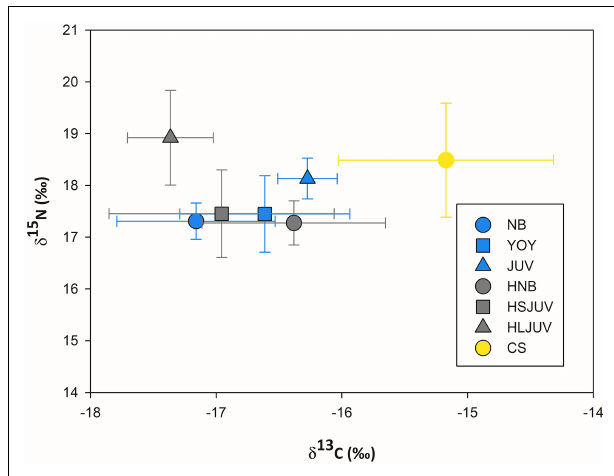
FIGURE 5 | Mean carbon and nitrogen stable isotope ratios ( ± SD) measured in the muscle of immature white sharks, smooth hammerheads and copper sharks from Bahía Sebastián Vizcaíno and the northern part of the Baja California peninsula. NB = newborn white sharks, YOY = young of the year white sharks, JUV = juvenile white sharks, HNB = newborn hammerheads, HSJUV = small juvenile hammerheads, HLJUV = large juvenile hammerheads and CS = copper shark.